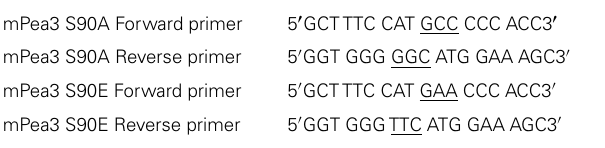
Table 2 | List of primers used for cloning phosphor-mutants of